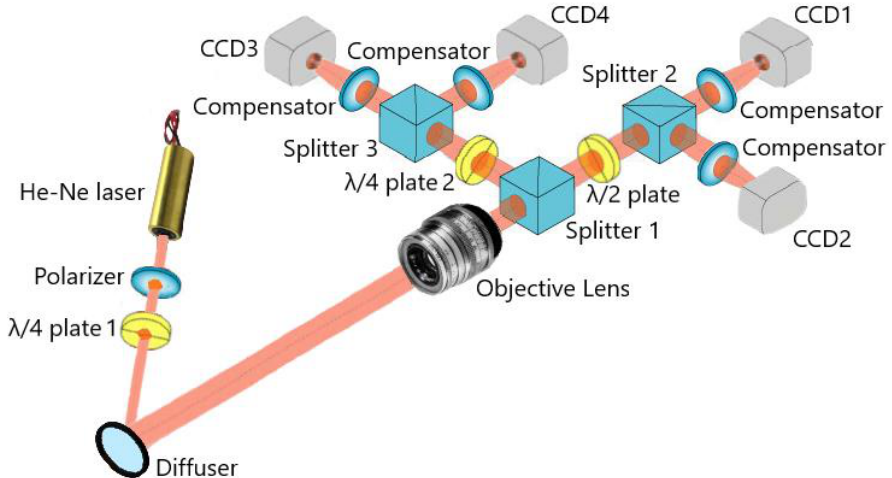
Figure 1. Optical scheme for calibrating the Stokes polarimeter.